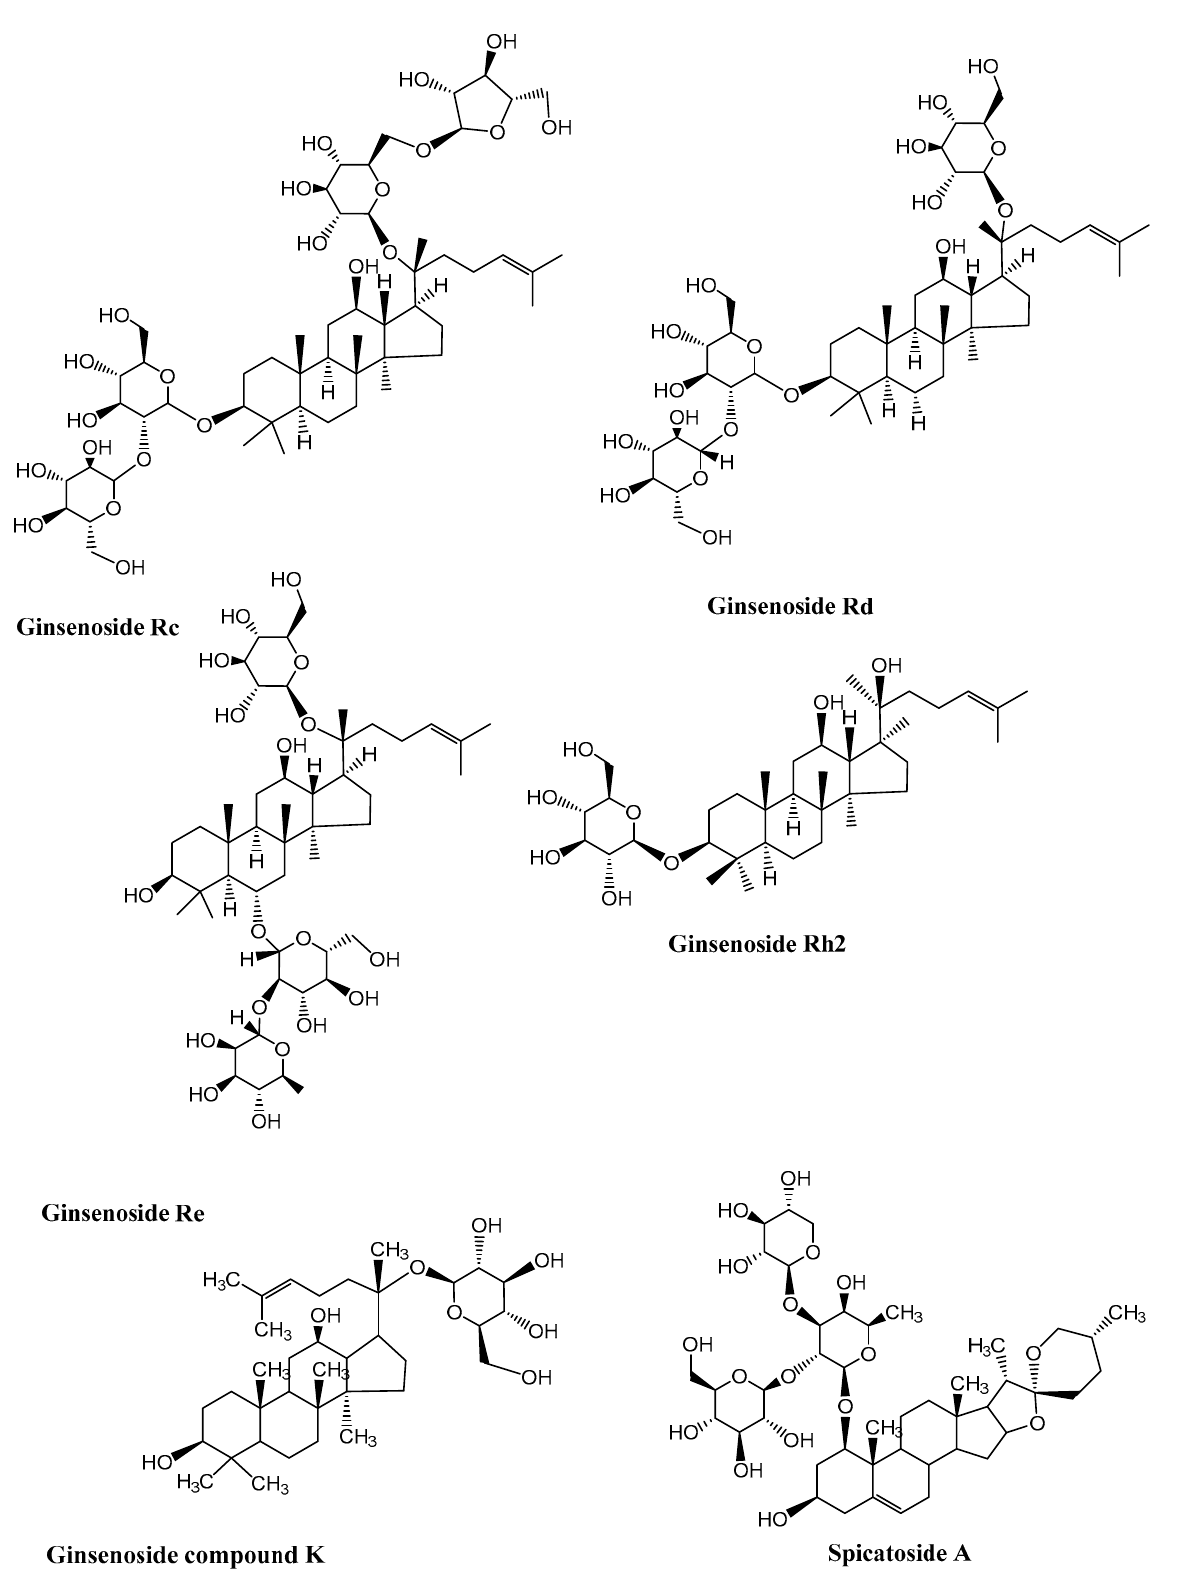
Figure 3. Chemical structure of neuroprotective saponins from ginseng. (Chemical structures were generated using ChemBioDraw ultra version 14).